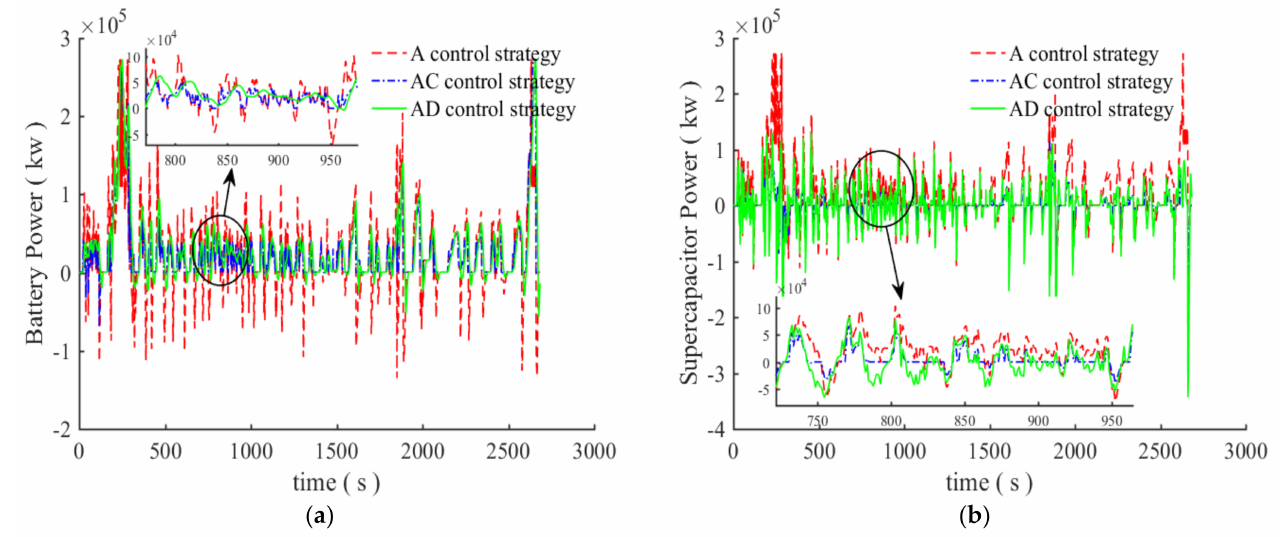
Figure 11. Power change diagram of the battery and supercapacitor: ( a ) battery power; ( b ) superca- pacitor power.